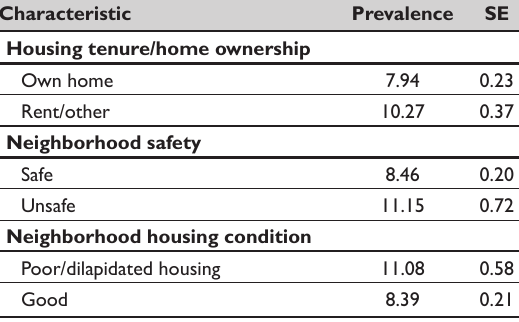
Table 1: Weighted prevalence (%) of current childhood asthma by selected socioeconomic